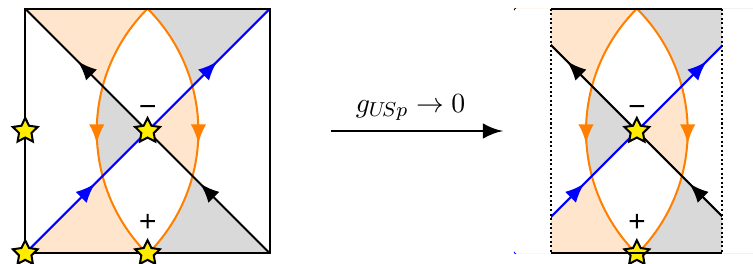
Figure 19. Sending the gauge coupling of the USp( N − 1) factor to 0. In terms of the brane tiling this amounts to stretching the torus horizontally so it becomes an infinite cylinder, or equivalently focusing on the region close to the SU